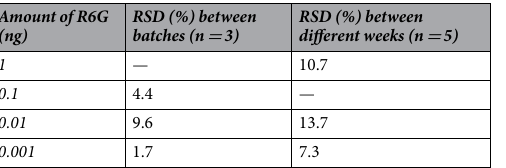
Table 1. Summary table of the RSD values regarding the reproducibility and time-stability